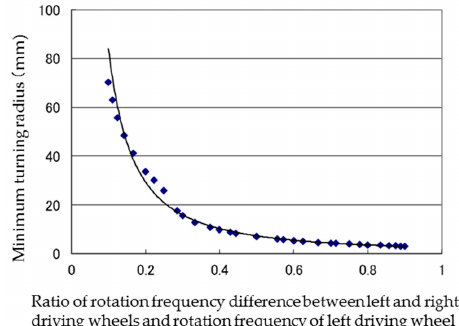
Figure 14. Relationship between ratio of rotation frequency difference between left and right driving wheels and rotation frequency of left driving wheel and minimum turning radius. The points show the calculation results. The solid curve shows the regression curve derived from these data.